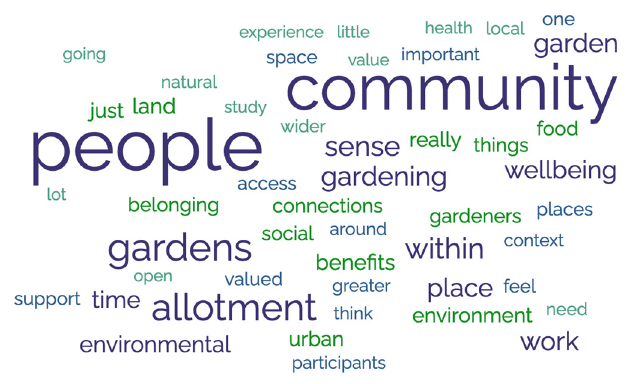
Figure 3. Word Cloud formulated from the Results and Discussion sections.